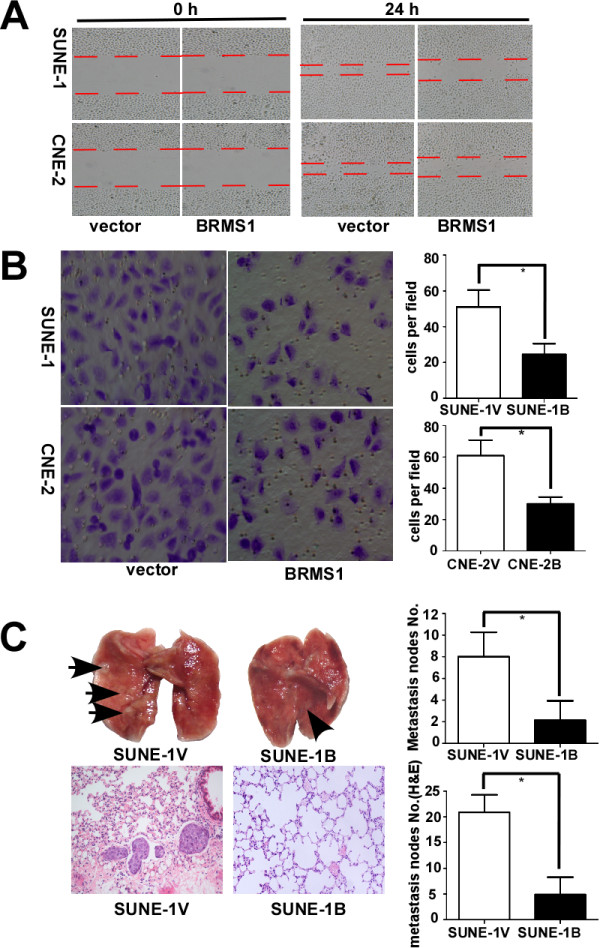
BRMS1 inhibits NPC cell migration and invasion in vitro and suppresses lung metastasis in vivo. (A) The effect of BRMS1 overexpression on cell migration in the wound healing assay. The right panels show a slower wound healing response in the BRMS1-overexpressing cells than in the vector control cells 24 h after scratching (magnification, 40×). (B) The effect of BRMS1 overexpression on cell invasion in the Transwell migration assay. The left panels are representative photomicrographs (magnification, 100×), while the right panels are the numbers of trans-membrane cells per field (magnification, 100×) counted in five random fields for each of the BRMS1-overexpressing and control groups in triplicate parallel experiments. (* p < 0.01; Student’s t-test). (C) BRMS1 overexpression inhibits metastasis in murine NPC xenografts. Mouse tumor xenografts were created (n = 8 per group). Representative macroscopic photographs of pulmonary metastases; the arrowheads indicate the metastatic nodules on the surface of the lungs (upper left in C). The average numbers of metastases in each group are shown in parallel on the right. Lung sections from each group were stained with hematoxylin and eosin (H&E) to quantify the degree of lung metastasis (lower left in C). Histograms depicting the average number of microscopic metastases in each group are shown on the right. (* p < 0.01; Student’s t-test).